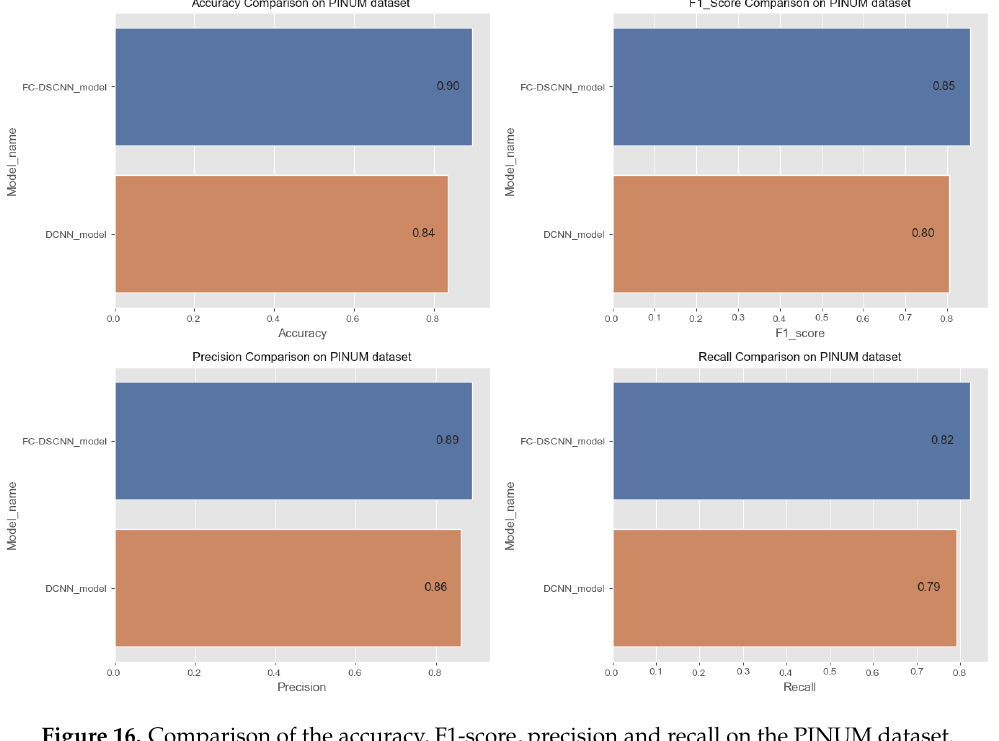
Figure 16. Comparison of the accuracy, F1-score, precision and recall on the PINUM dataset.